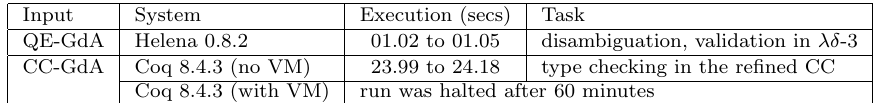
Fig. 15. Main reduction steps of the RTM.